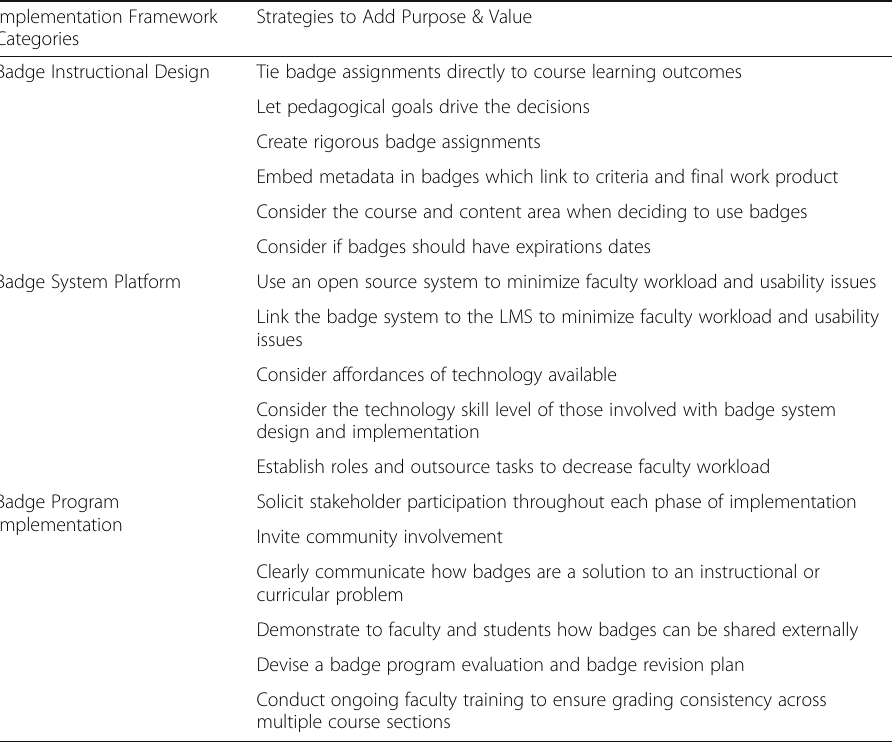
Table 3 Strategies to Implement Badges with Purpose and Value Implementation Framework Strategies to Add Purpose & Categories